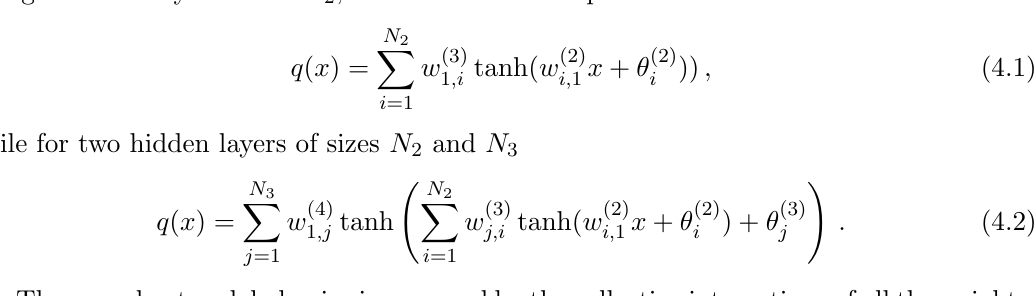
Figure 7 . x -space PDF’s reconstructed using the Backus-Gilbert (BG) method from N (cid:23) = 23 Io(cid:11)e-time data points on the interval (cid:23) = [0 ; 20] (top) and from N (cid:23) = 112 Io(cid:11)e-time data points on the interval (cid:23) = [0 ; 100] (bottom). The plots in the left column show the results for mock data based on a phenomenological PDF, while the right column from the modi(cid:12)ed scenario where the PDF vanishes at the origin. The reconstruction was performed with preconditioning exponents a = 0 : 35 and b = 2 for scenario A and a = 0 : 3 and b = 2 for scenario B. It is noteworthy (cid:0) that by having lattice data up to (cid:23) max = 20 one can achieve a very good reconstruction with